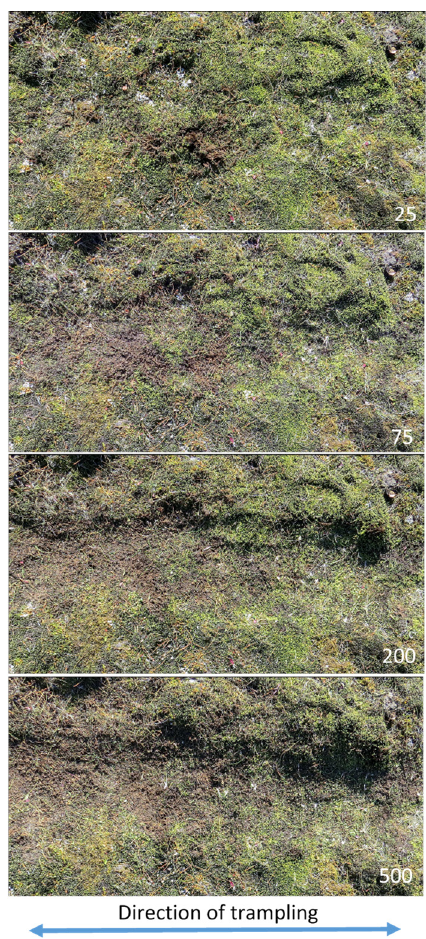
Figure 7. Sequence of photographs from the highland moss-heath plot, showing how the vegetation is changing and deteriorating with increased trampling (i.e., 25, 75, 200, and 500 hikers). Each photograph covers a ~0.76 × 0.4 m area.